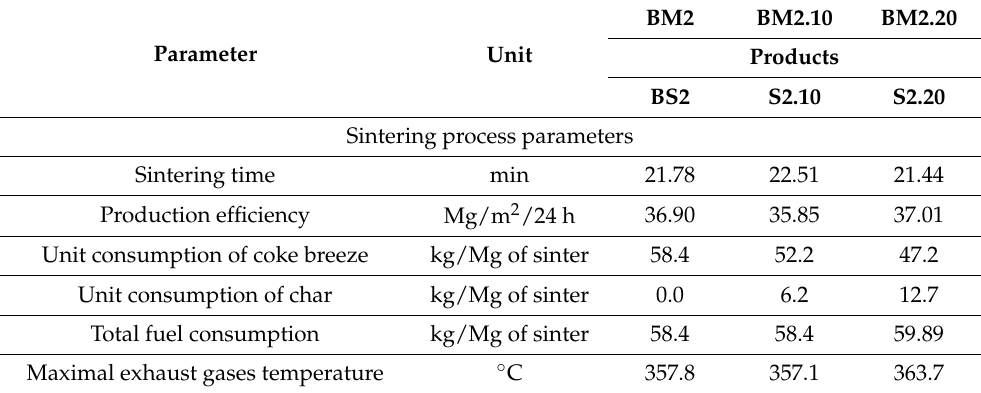
Table 6. Technological parameters of the sintering process for BM2, BM2.10, and BM2.20 and sinter